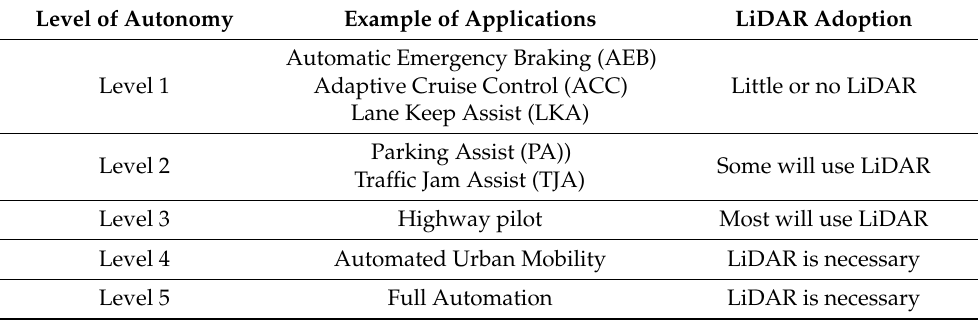
Table 2. Examples of LiDAR uses in vehicle safety